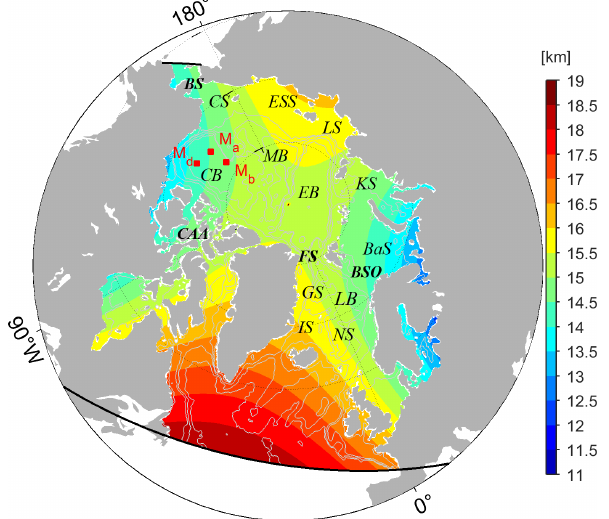
Figure 1. Map of the pan-Arctic regions showing the model domain (enclosed by the black lines) and horizontal resolutions (shading). The red rectangles show the three moorings (M a , M b , M d ) from the Beaufort Gyre Exploration Project (BGEP). Major basins and straits are labeled as follows: Canada Basin (CB), Makarov Basin (MB), Eurasian Basin (EB), Chukchi Sea (CS), East Siberian Sea (ESS), Laptev Sea (LS), Kara Sea (KS), Barents Sea (BaS), Greenland Sea (GS), Lofoten Basin (LB), Iceland Sea (IS), Norwegian Sea (NS), Bering Strait (BS), Fram Strait (FS), Barents Sea Opening (BSO), and Canadian Arctic Archipelago